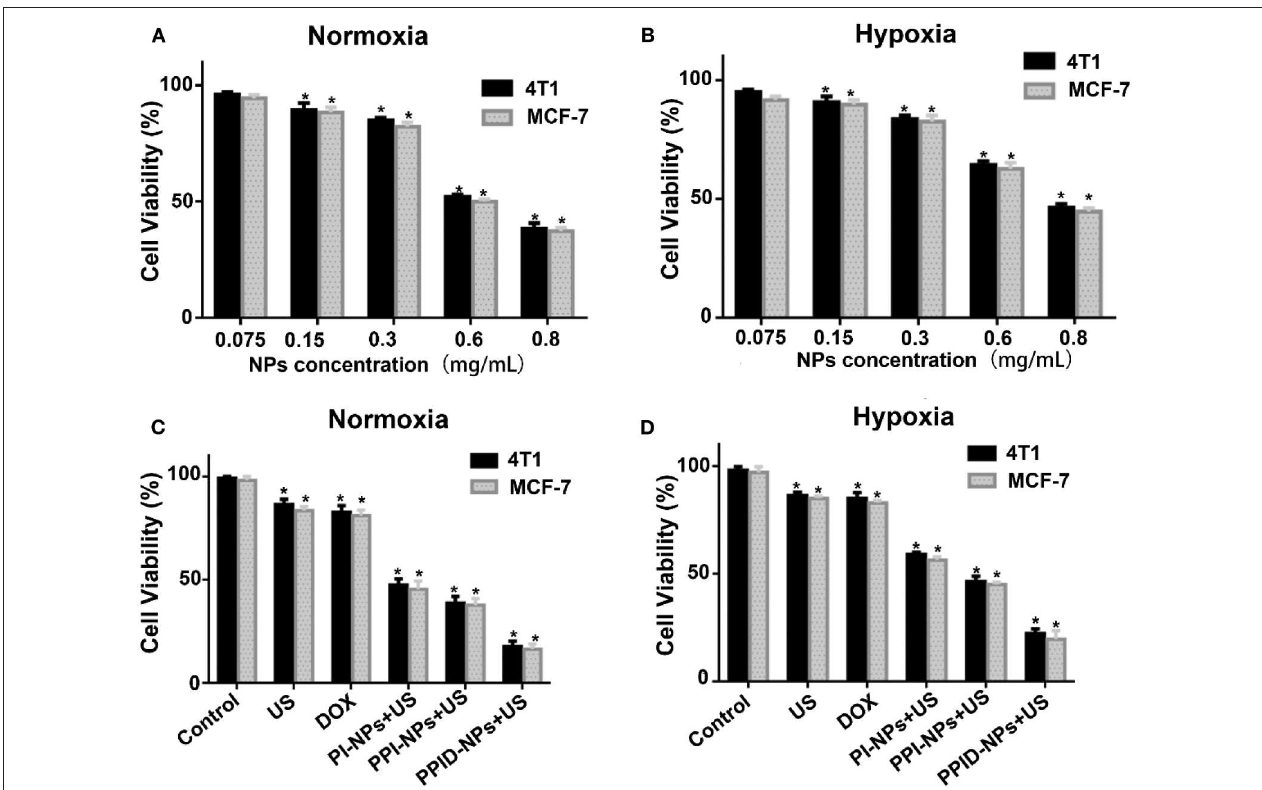
FIGURE 4 | (A,B) Cell viability of 4T1 and MCF-7 cells incubated with different concentrations of PPID-NPs under normoxia environment (A) and hypoxia environment (B) (* p < 0.05, compared with the 0.075 mg/mL nanoparticles concentration group). (C,D) Cell viability of 4T1 and MCF-7 cells under different treatments in normoxia environment (C) and hypoxia environment (D) (* p < 0.05, compared with the control